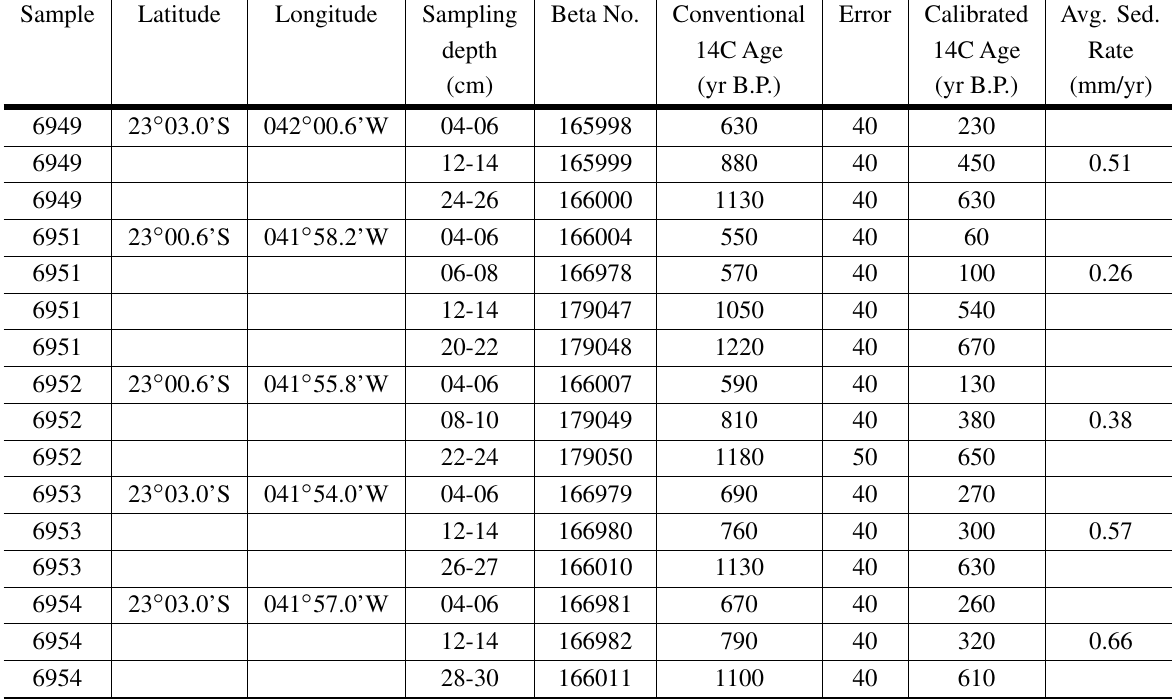
Location, radiocarbon ages and average and sedimentation rates of the